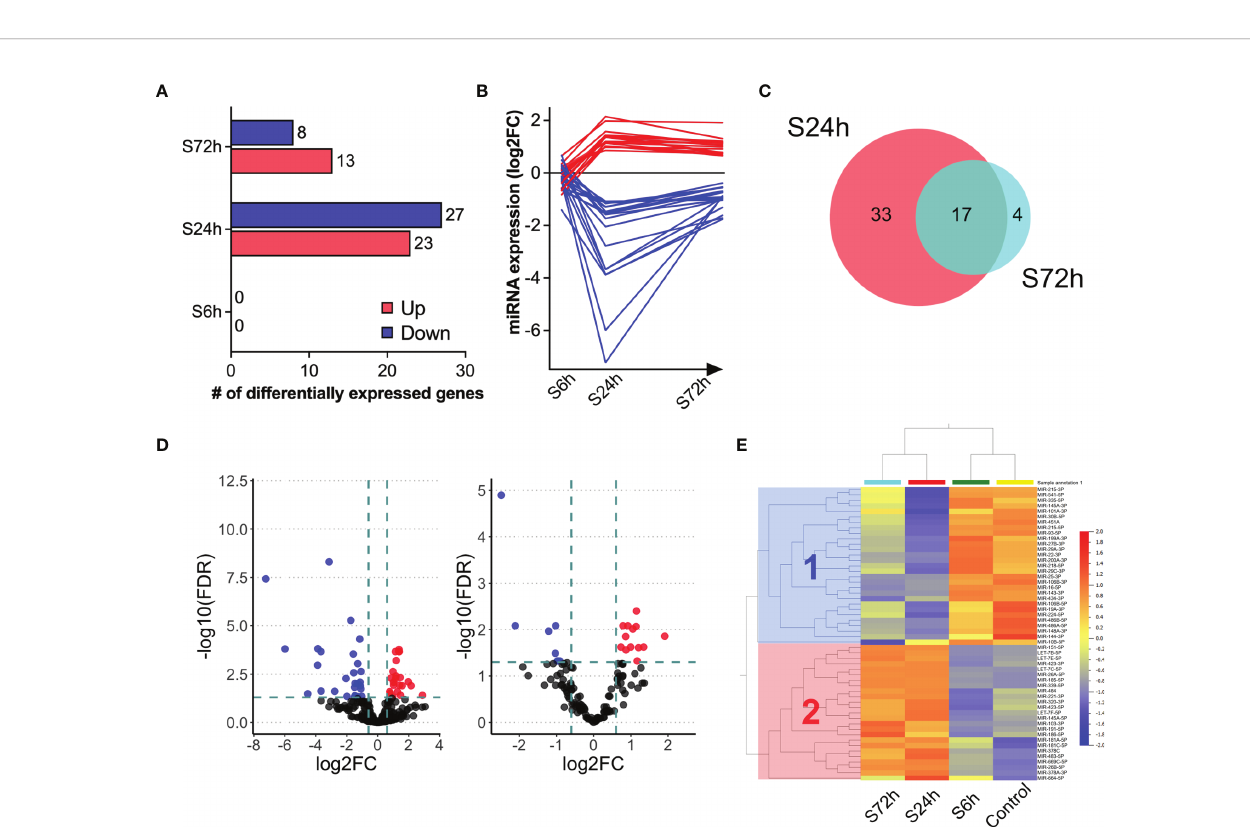
FIGURE 6 | Differential expression of miRNAs in the post-surgery circulating EVs. (A) Bar diagram representing the number of differentially expressed miRNAs in the 6, 24, and 72 h post-surgery groups compared to control values as assessed by DESeq2 analysis (FDR<0.05 and fold change (FC)>1.5; see Materials and Methods ). (B) Post-surgery temporal kinetics of the differentially expressed miRNAs. Each line represents an individual differentially expressed miRNA. (C) Volcano plots showing the differentially expressed proteins at 24- (left) and 72 h (right) post-surgery compared to the control group (Control). The dotted lines represent FC > 1.5 threshold (log2-FC) and FDR <0.05 (-10logFDR), respectively. (D) Venn diagram showing the overlap between the differentially expressed miRNAs at 24 and 72 h post-surgery. (E) The log2-transformed CPM values of differentially expressed miRNAs at 24 and 72 h and the same miRNAs from the control and S6h groups were used to generate heatmap (Qlucore). Cluster 1 (blue) and cluster 2 (red) include down-regulated and up-regulated miRNAs at 24 and 72 h,